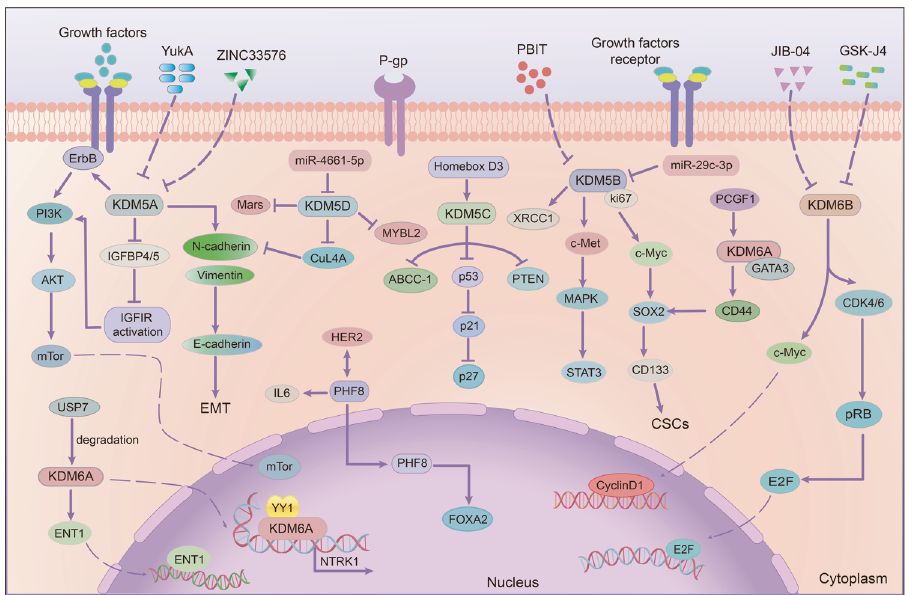
Fig. 11 The roles of KDM5-7 on drug resistance. In KDM5 family, KDM5A can promote PI3K/AKT/mTOR pathway through ErbB and induce EMT in combination with KDM5D inhibition, thereby leading to drug resistance. However, KDM5C exerts opposite effects by regulating PTEN and p53, PBIT can inhibit the demethylase activity of KDM5B, which in turn affects the MAPK pathway and cell stemness. Besides, KDM6A and KDM6B can enhance drug resistance by promoting cell stemness and regulating the cell cycle, respectively. Importantly, PHF8 can also